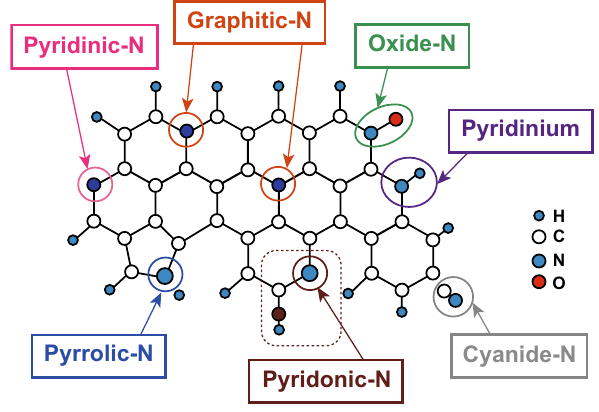
Fig. 2 Common forms of nitrogen species in nitrogen-doped carbon materials. Reproduced with permission from Ref. [12]. Copyright permissions from Wiley–VCH. (Color figure